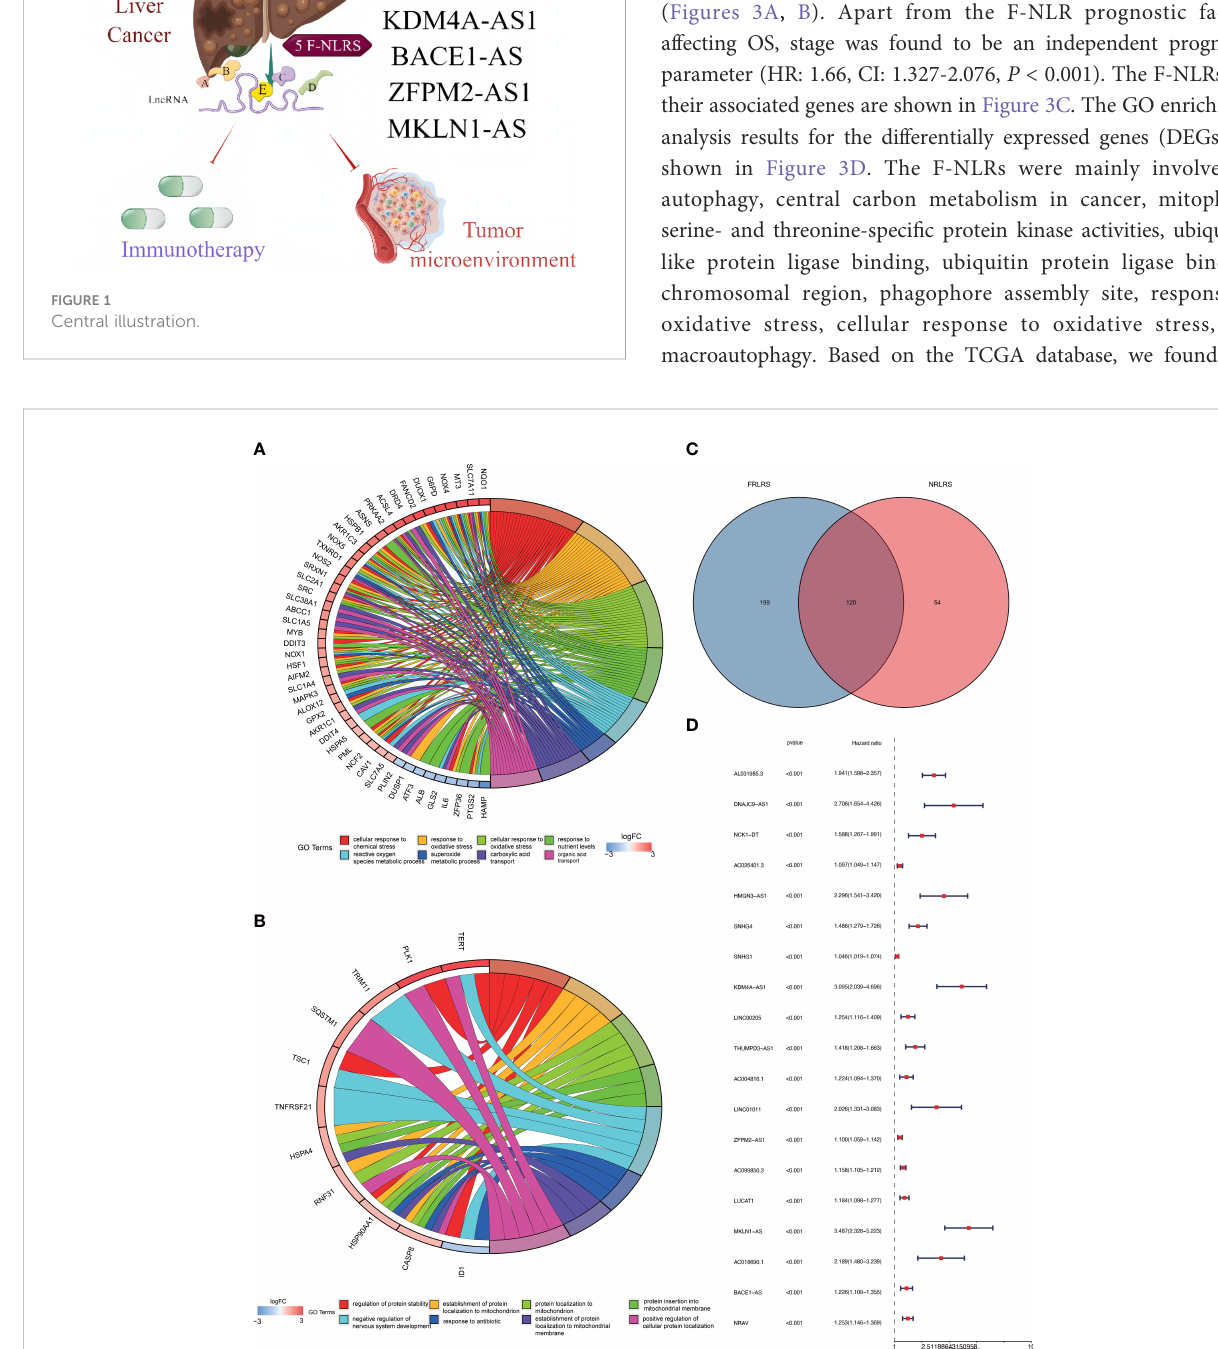
FIGURE 2 (A) GO enrichment analysis of ferroptosis-related genes (FRGs). (B) GO enrichment analysis of necroptosis-related genes (NRGs). (C) Venn diagram of ferroptosis-related lncRNAs (FRLRs) and necroptosis-related lncRNAs (NRLRs). (D) Univariate Cox regression analysis of identi fi ed lncRNAs.